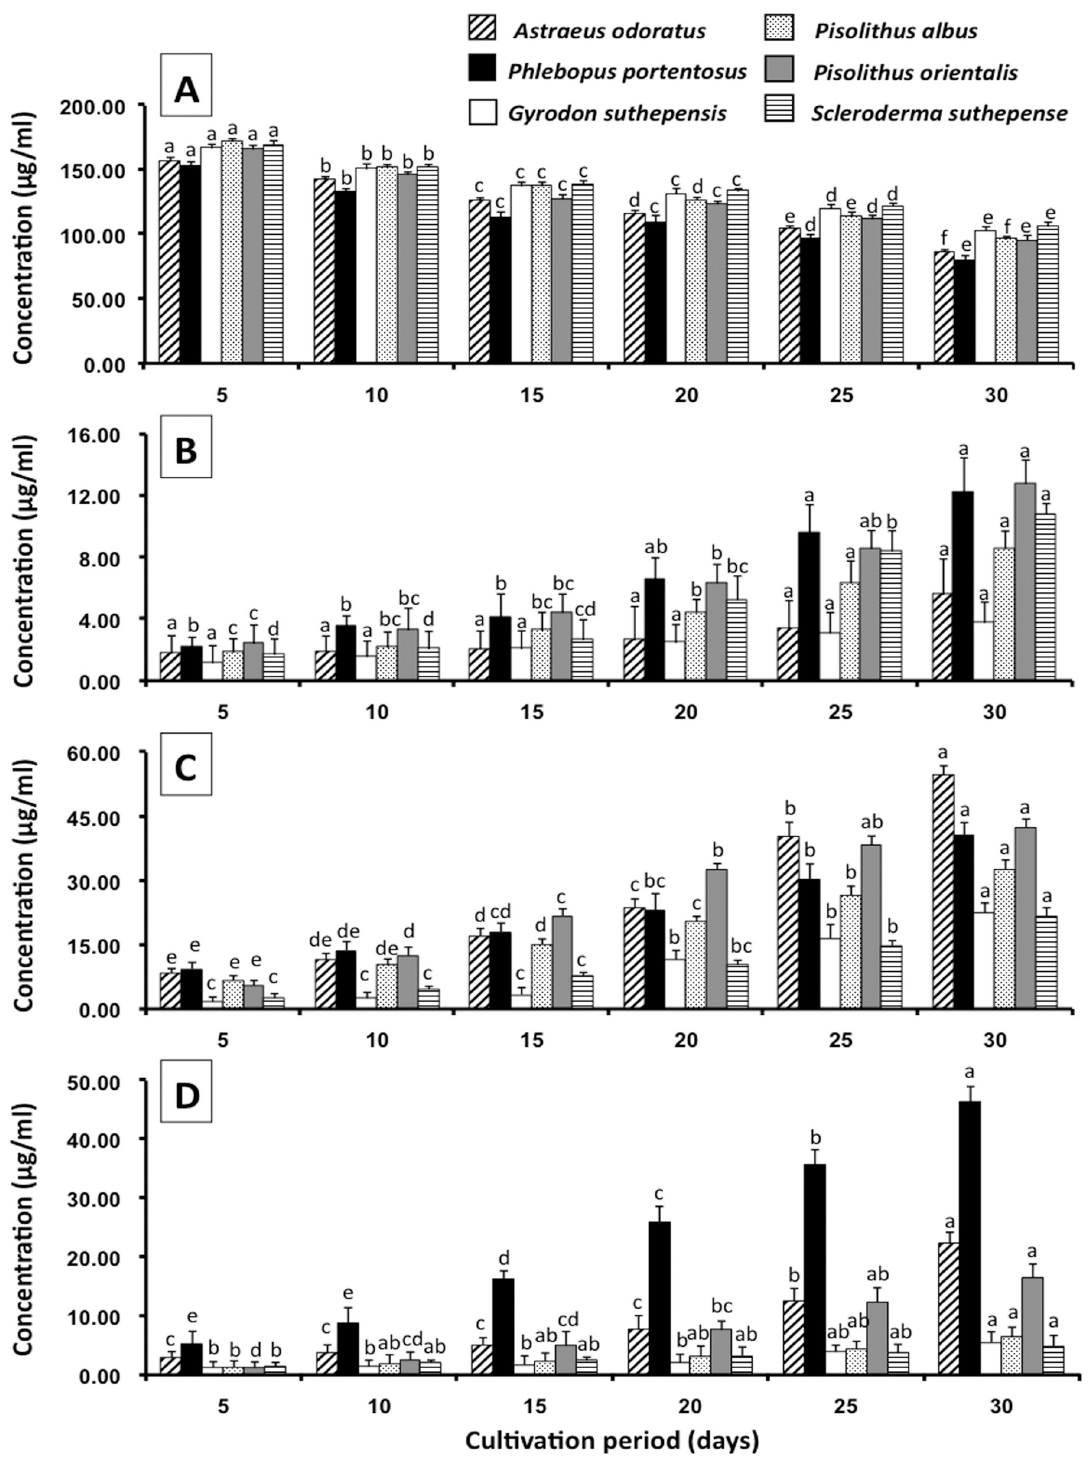
Fig 3. Indole compounds produced by ectomycorrhizal fungi in different cultivation periods. A. L- tryptophan, B. Indole-3-lactic acid. C. Indole-3-acetic acid. D. Indole-3-ethanol. The results are means of three replicates ± SD. Different letters above each graph indicate the significant difference ( P <